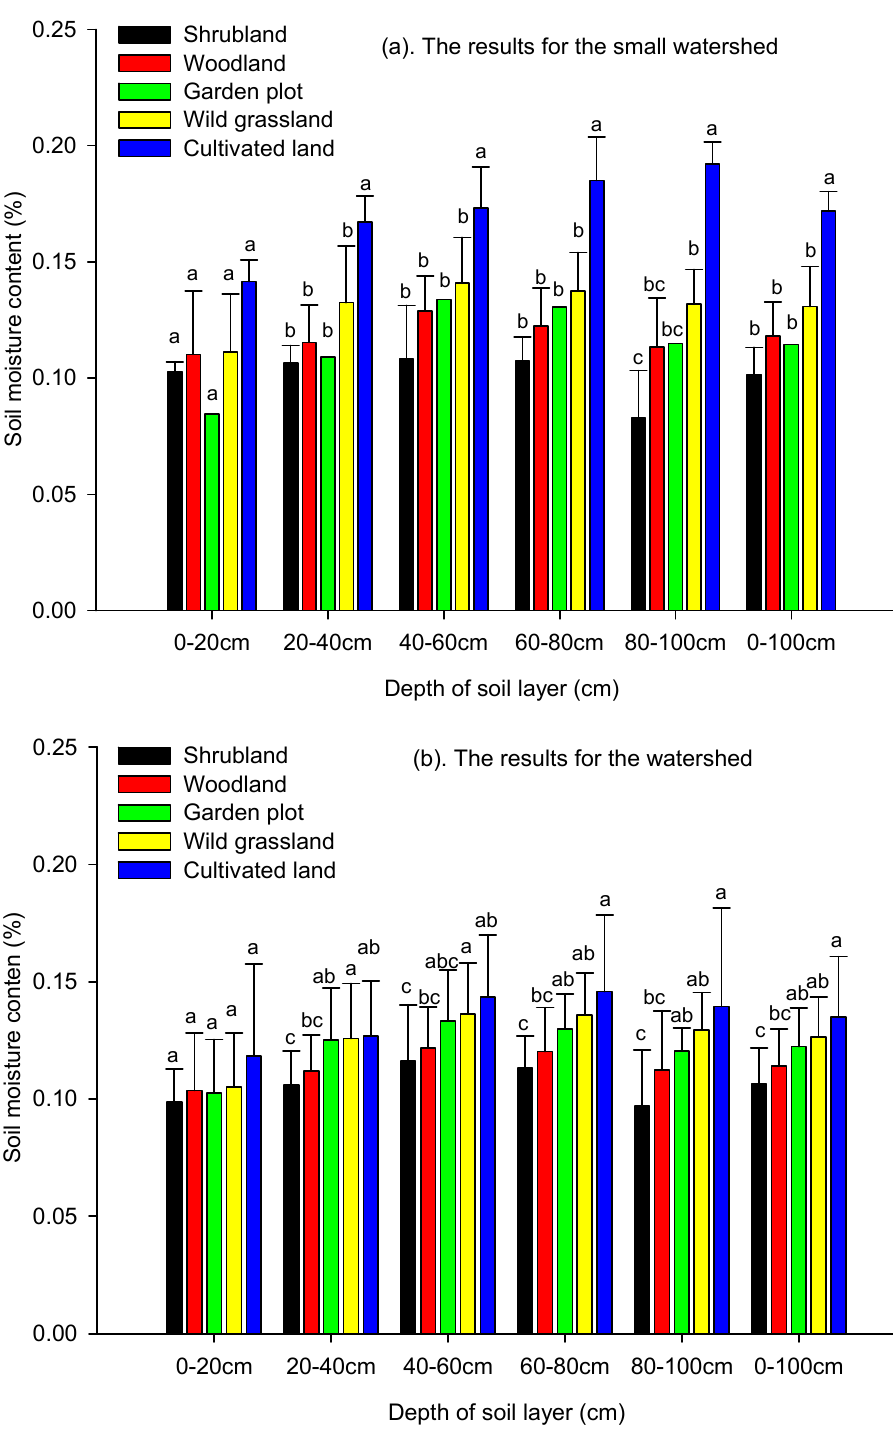
Figure 2. Difference in soil moisture value for different land use